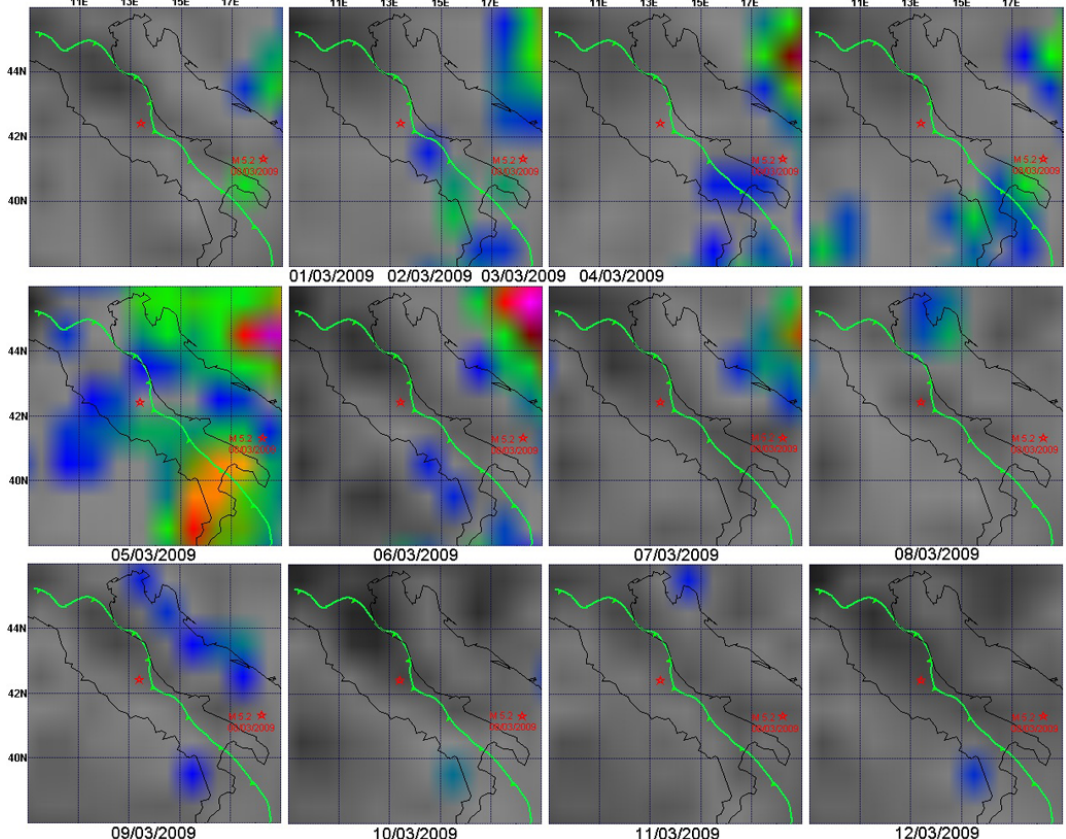
Fig. 4. Spatial-time evolution of the temperature changing based on the NCEP data (all at 00:00UTC) in the cycle